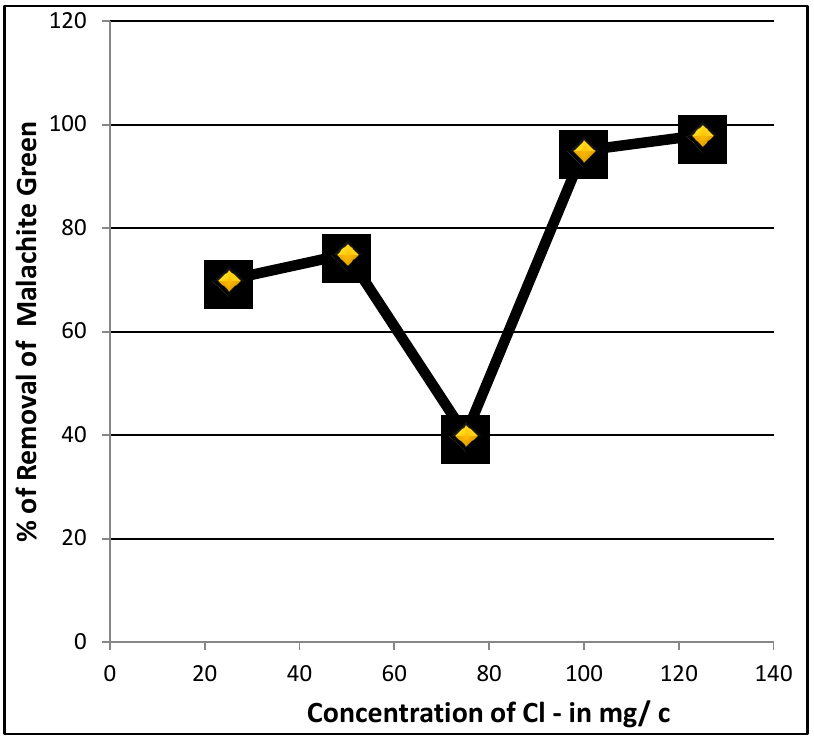
Figure 8. Effect of other ions on the removal of malachite green dyes. [MG]= 100mg/L: adsorbent dose = 25 mg / 50ml: contact time =